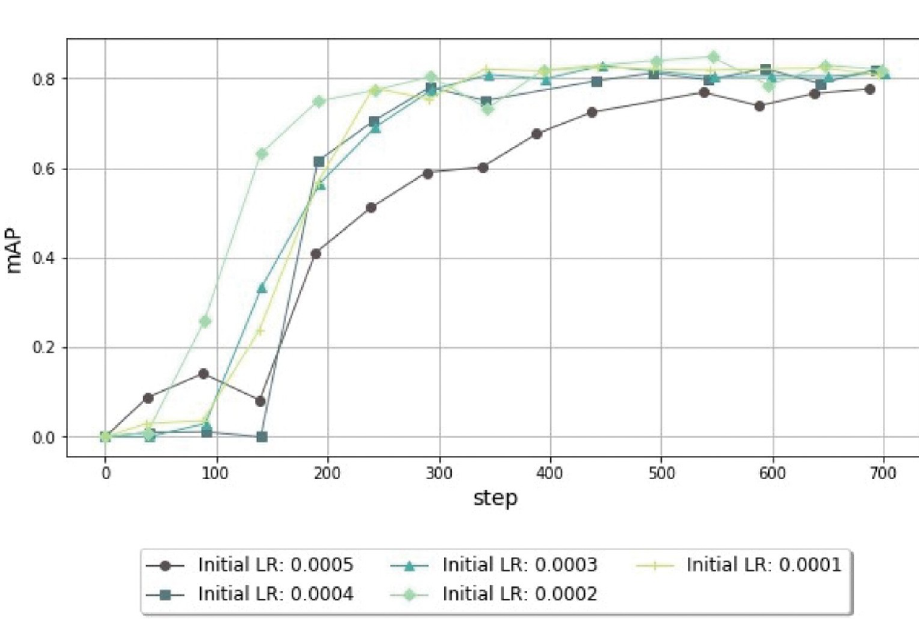
Fig 8. Comparison of mAP values from the object-detection models trained using different initial learning rates (LR) for 700 steps. After a set of experiments where we test the learning rate with different orders of magnitude, the range of values between 0.0001 and 0.0005 leads to an improvement in the mAP. In this range, the value of 0.0002 results in faster convergence.